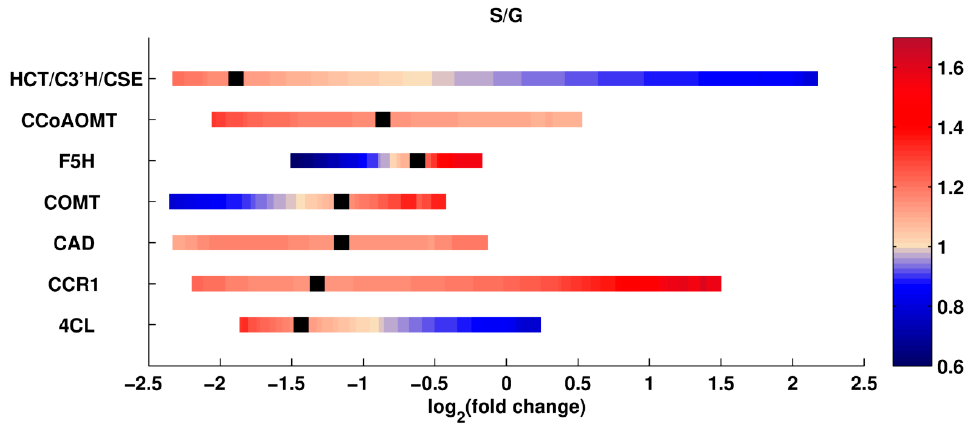
Figure 7. S/G ratio in overexpressed PvMYB4 plus an additional single enzyme perturbation. The color code is the same as in Figure 3. The black squares represent the reference amount of the corresponding enzyme in the PvMYB4 experiment. The S/G ratio can be significantly changed compared to the background PvMYB4 experiment. A change in F5H can alter the S/G ratio dramatically in a narrow perturbation interval.